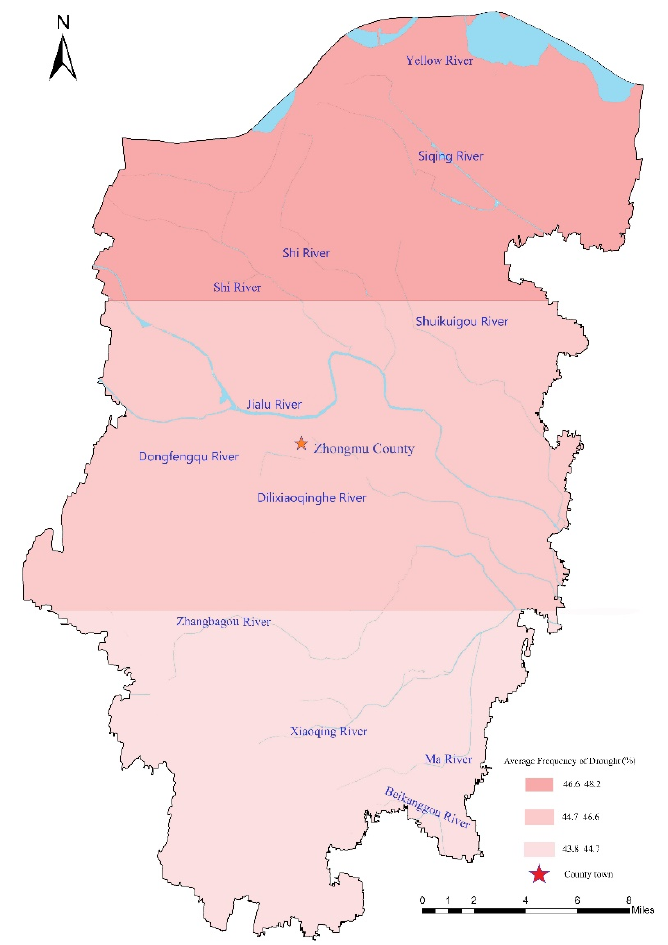
Figure 7. Annual drought frequency distribution of winter wheat.